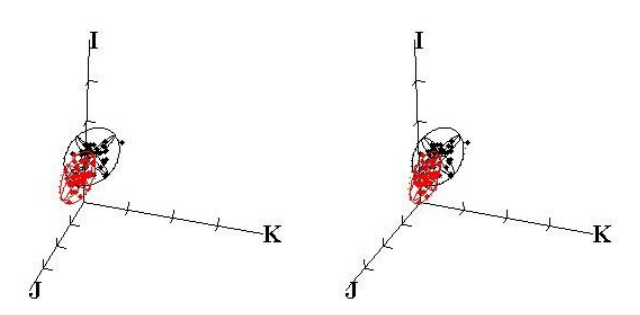
Figure 2b. Scatter plot (excluding the 95% distribution ellipsoids) of P1: 50 auto-keratometric measurements taken before (black data points) and P2: 50 auto-keratometric measurements taken after (red data points) three hours of PMMA contact lens wear. This scatter plot has been rotated so that the data points can be viewed looking down the oblique antistigmatic ( K ) axis. The origin of the scatter plot is 41.85 I D.